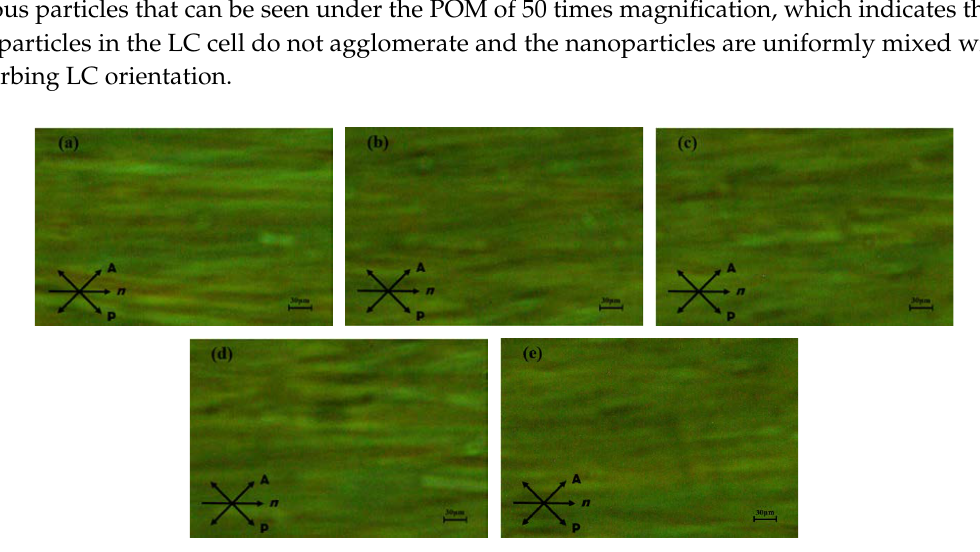
Table 1. The physics properties of liquid crystal (LC) with and without nanoparticles.